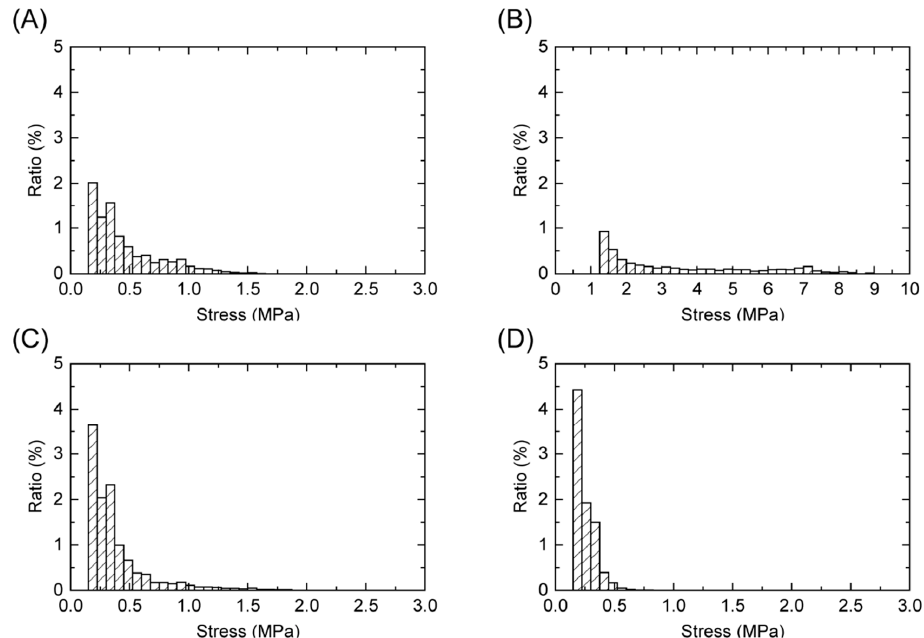
Figure 4. Pressure distribution obtained using pressure measurement films. ( A ) AP32, ( B ) AP16, ( C ) GFRTP, and ( D ) CFRTP.